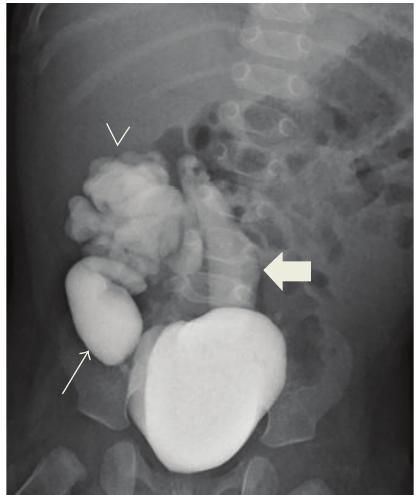
Figure 2: VCUG, 6 months of age: dilated atretic right ureter with high grade vesicoureteral reflux (arrow), high grade vesicoureteral reflux into tortuous left ureter that lies to the left of midline (block arrow), and the dilated left collecting system with blunting of the calyces to the right of midline (arrowhead), suggestive of left crossed fused renal